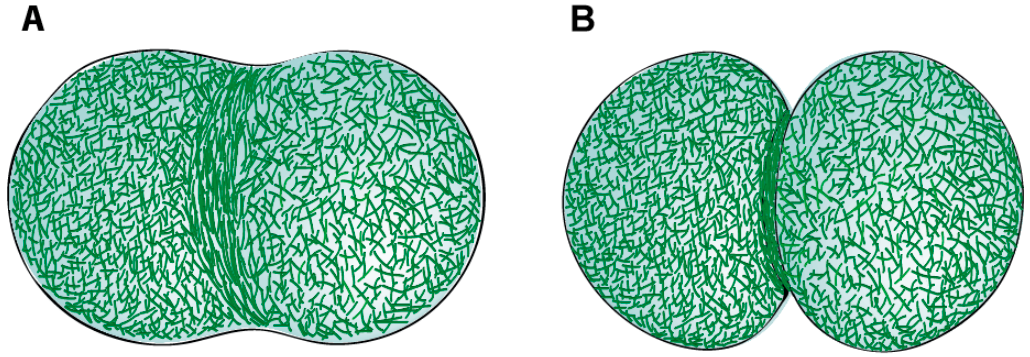
Figure 1. During cytokinesis, an actomyosin contractile ring (CR) specializes from and remains integrated in the cell cortex. The cartoon depicts network architectures in the contractile ring and surrounding cell cortex (A) at ring assembly and ( B ) during ring constriction.